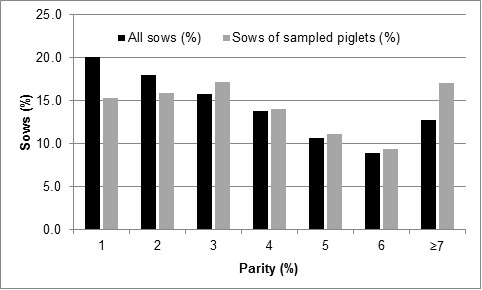
Age structure of sows within the herds and those whose piglets were sampled.